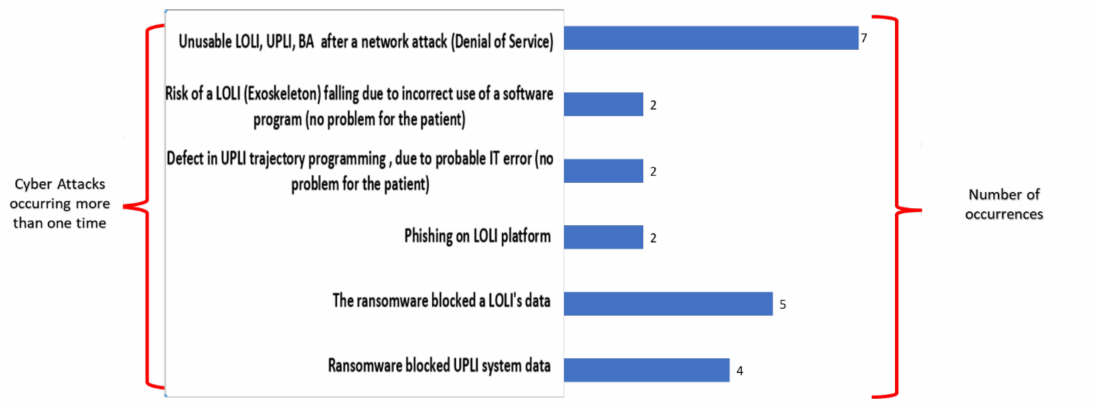
Figure 8. Experiences with cyber-attacks which occurred more than one time after